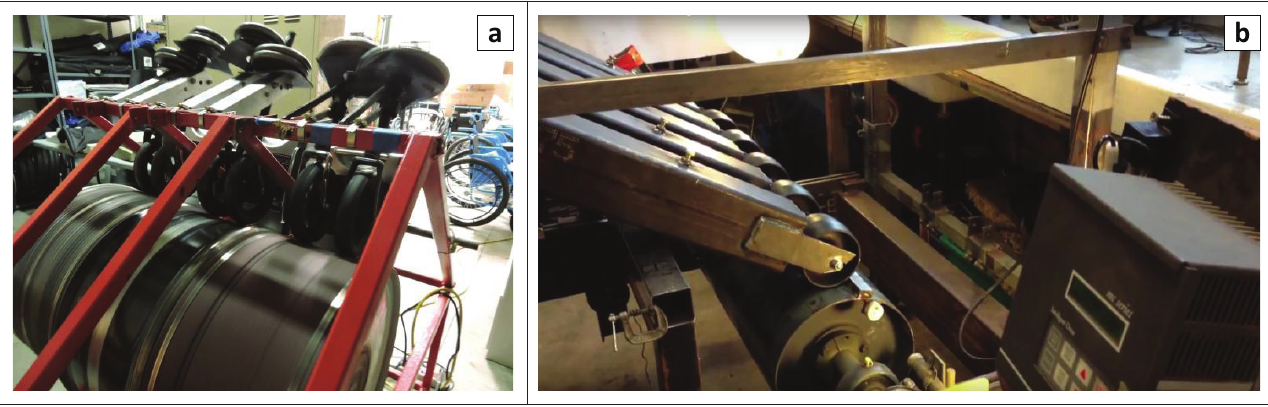
FIGURE 5: Caster testing drum equipment with wheelchair manufacturers.